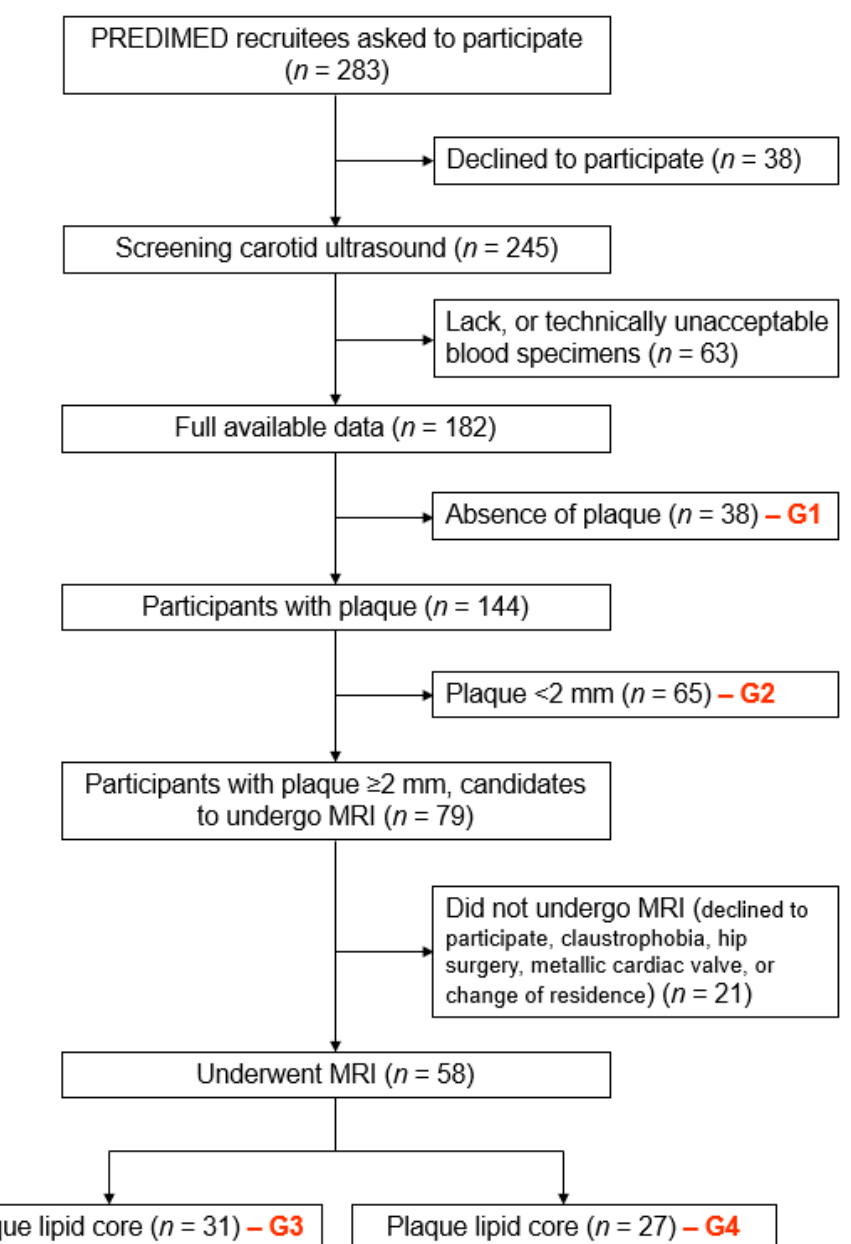
Figure 1. Flow-chart of the study. “PREDIMED” denotes “PREvención con DIeta MEDiterranea”; “G” denotes group; “MRI” denotes “magnetic resonance imaging”.